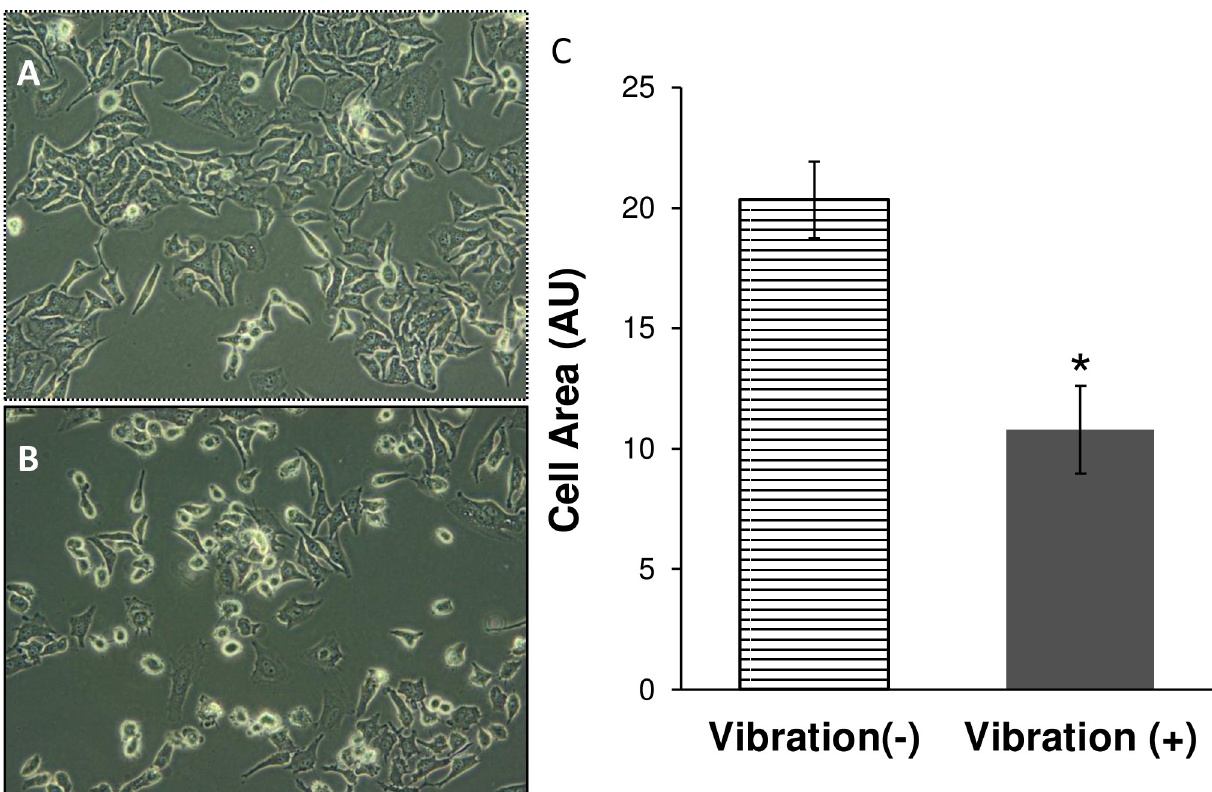
Fig 1. Vibration induces a cell shape change consistent with loss of established filopodia. Representative phase contrast micrographs of HeLa cells without vibration (A) and with vibration (B) at 200x total magnification. (C) The perimeter of each cell ( � 100) was delineated including any protrusions and the cell area was measured (arbitrary units, AU). Data shown as average cell area (AU) for all cells measured ( ± sem for three independent experiments). � = p < 0.05 Vibration (+) [solid bar] vs. Vibration (-) [striped bar].